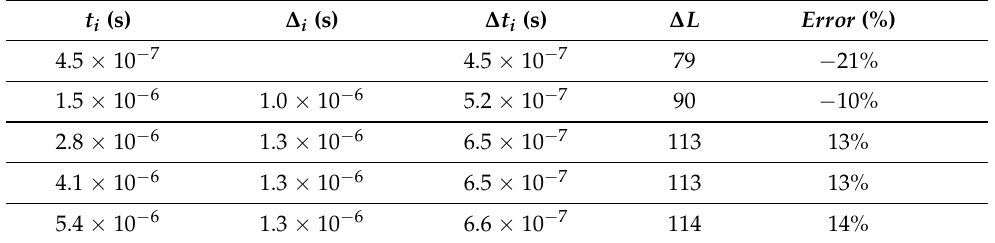
Table 1. Distance calculations based on raw data without applying any processing technique.